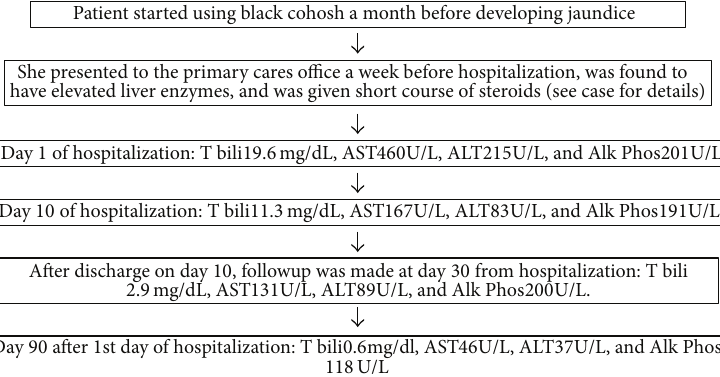
discharge on day 10 , followup was made at day 30 from hospitalization: T bili 2.9 mg/dL, AST 131 U/L, ALT 89 U/L, and Alk Phos 200 U/LDay 90 after 1 st day of hospitalization: T bili 0.6 mg/dl, AST 46 U/L, ALT 37 U/L, and Alk 118 Figure 2: Flow chart showing sequence of events. The black cohosh dechallenge was begun from day 1 of hospitalization. LFTs normalized within 90